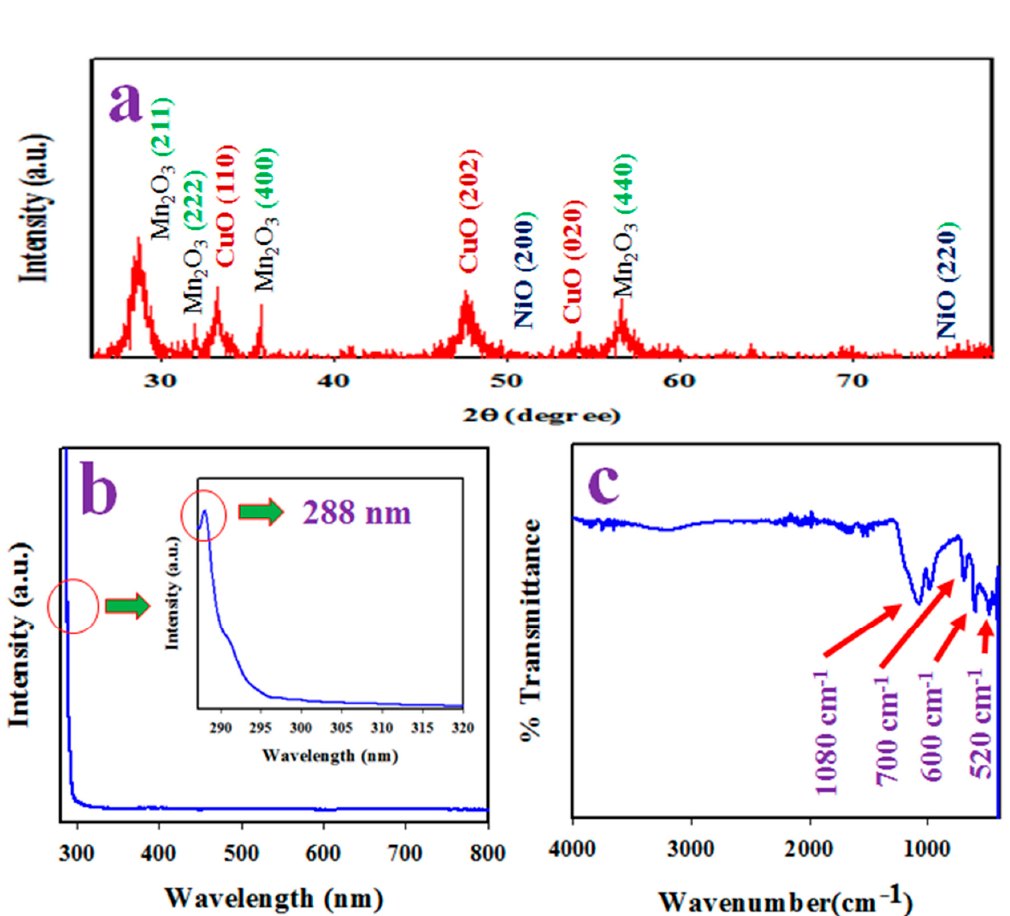
Figure 3. XRD, UV-vis and FTIR analysis of CMNO nanomaterials. ( a ) Crystallinity of CMNO NMs by XRD analysis, ( b ) UV-vis absorbance analysis and ( c ) the existing functional group investigation using FTIR analysis.